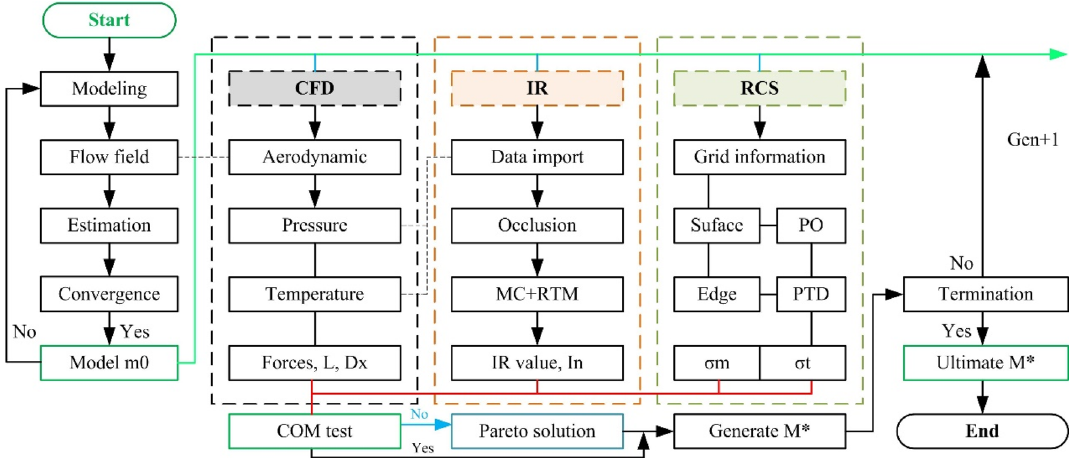
Figure 2. Flow chart of the comprehensive design method, drawn using Microsoft Visio